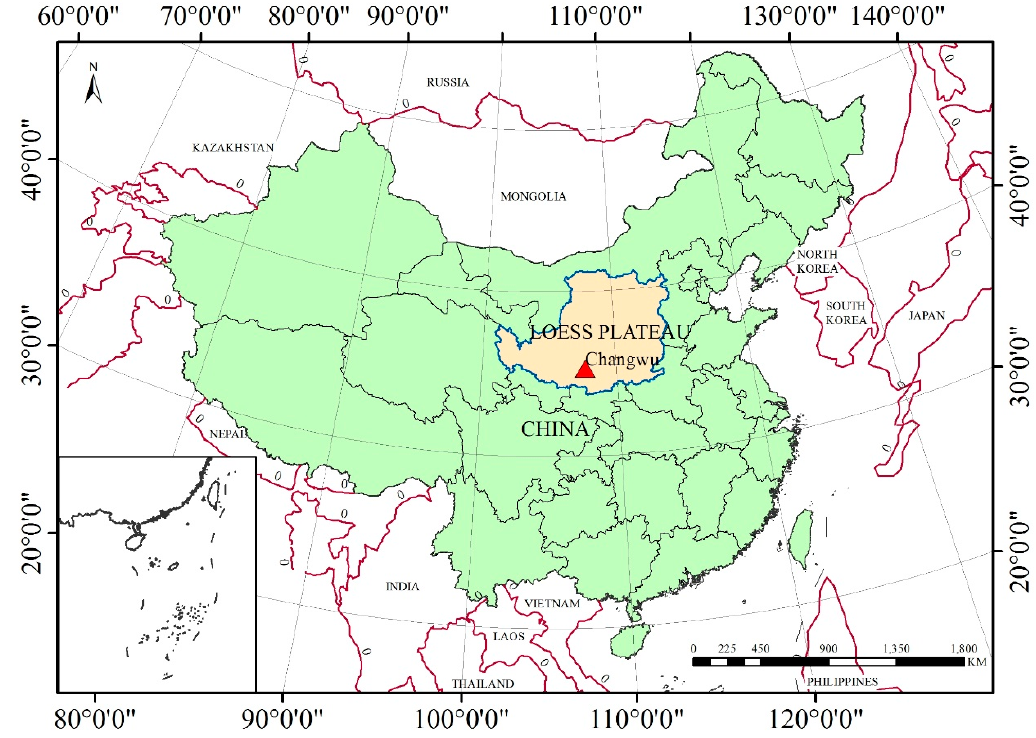
Figure 1. The location of the study area in the Loess Plateau, China.